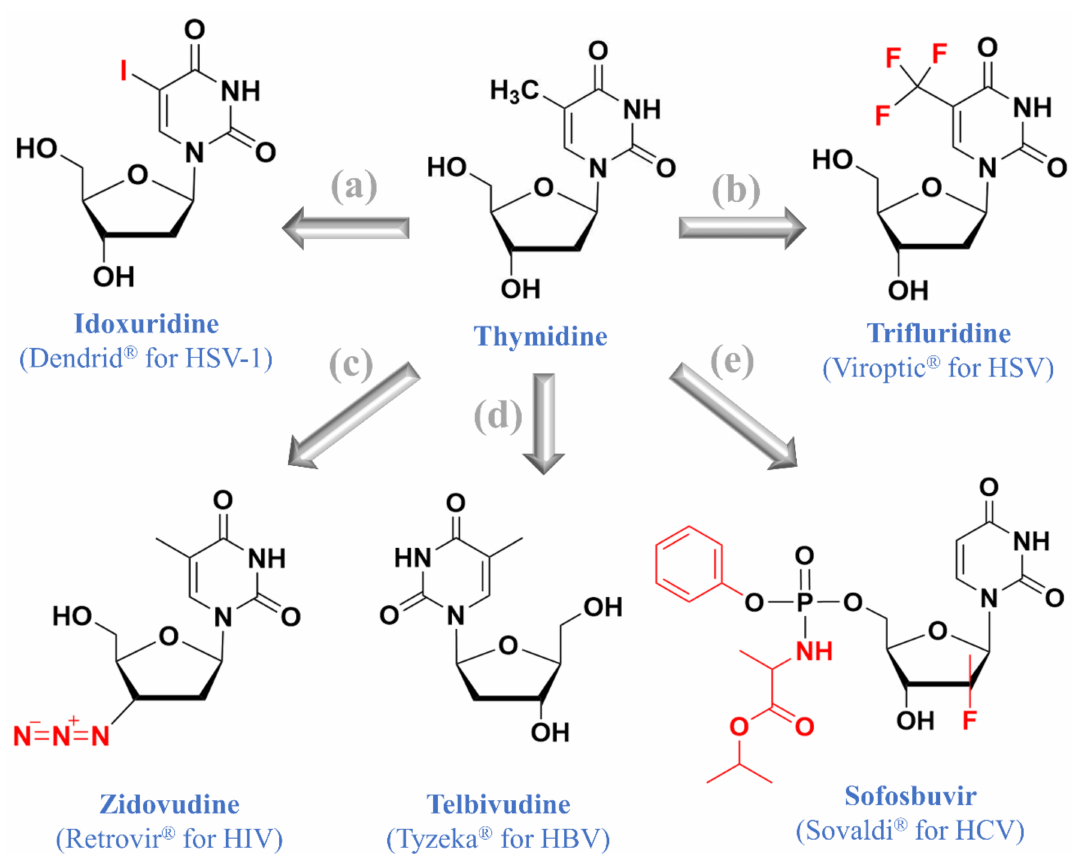
Figure 2. Thymidine and five approved thymidine nucleos(t)ide analogues: ( a ) idoxuridine, ( b ) trifluridine, ( c ) zidovudine, ( d ) telbivudine, and ( e )